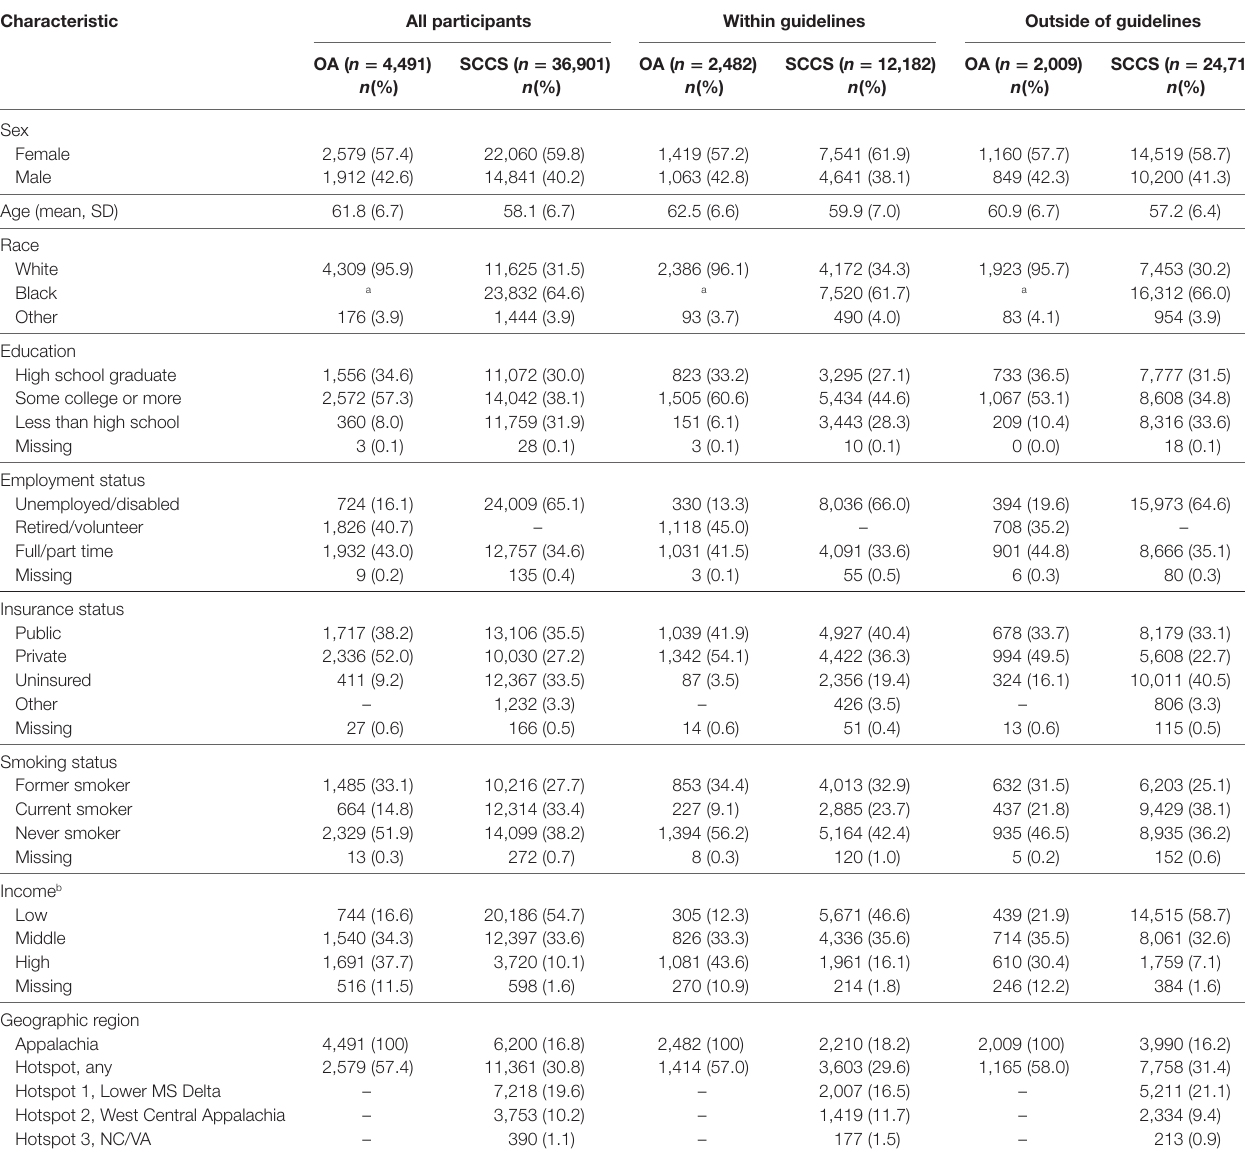
TaBle 1 | Characteristics of Ohio Appalachia (OA) and Southern Community Cohort Study (SCCS) participants by colorectal cancer guideline-concordant screening status.